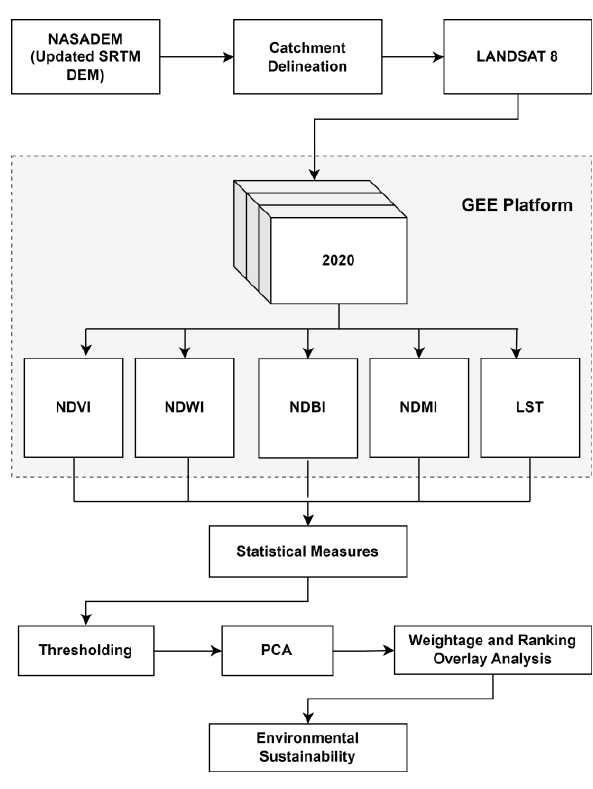
Figure 2. Flow Chart showing the methodology